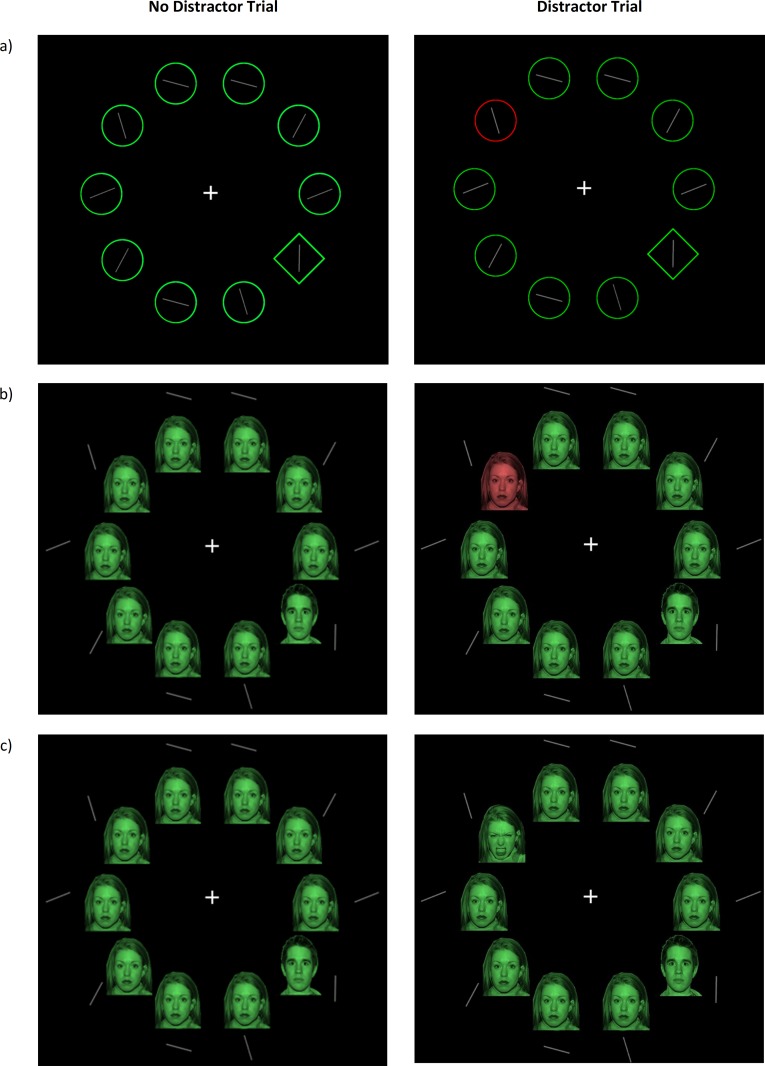
Example of no-distractor and distractor trials for each of the three tasks used in the study: a) Shapes task, b) Faces-color task, c) Faces-valence task.In shapes task example, on both trials a diamond is a target shape and participants are required to indicate by button press that the line inside is vertical. On a distractor trial one of the circles in the array is of a task-irrelevant distractor of opposite color (red).In faces-color and faces-valence tasks examples, a male face is a target face and participants are required to indicate by button press that the line next to it is vertical. In faces-color task example on a distractor trial one of the female faces in the array is of a task-irrelevant distractor of opposite color (red). In faces-valence task example on a distractor trial one of the female faces in the array is of a task-irrelevant distractor of opposite valence (an angry facial expression).